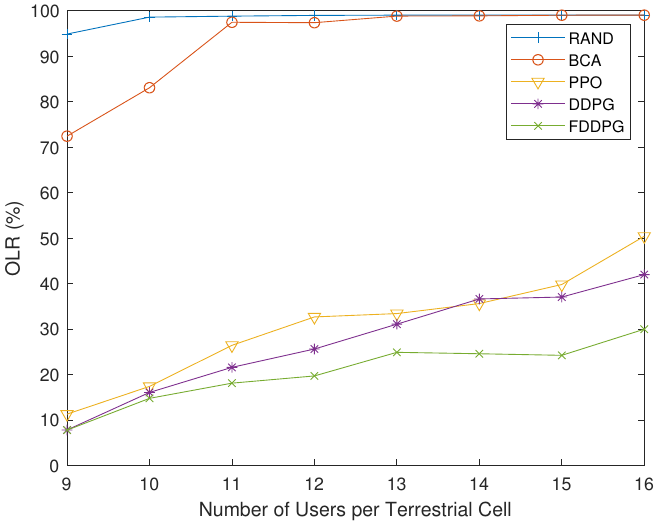
Figure 5. The overload ratio with different algorithms.